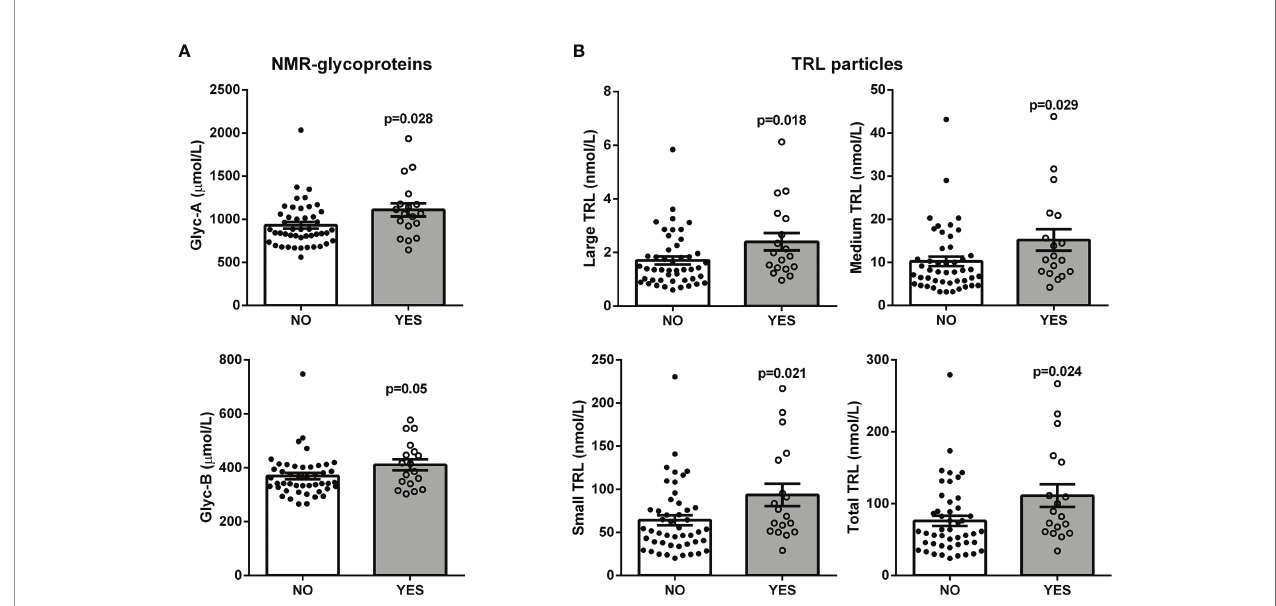
FIGURE 3 | Scatter plot with bar graphs of the plasma baseline levels of the NMR-measured glycoproteins (A) and TRL particles (B) in patients with ultrasound- con fi rmed hepatic steatosis after a 10-year follow-up. Each dot represents a patient: black dots for disease-free patients and white dots for patients with steatosis; bars represent mean values; p-values from Mann-Whitney U tests. Linear multivariate analysis controlled by age, sex and BMI: Glyc-A, p = 0.062; Glyc-B = 0.289; Large TRL-P, p = 0.001; Medium TRL-P, p = 0.004; Small TRL-P, p = 0.003; Total TRL-P, p = 0.003. In our study, we found a strong and positive association between all TRL particle subclasses and 1 H-NMR-measured glycoproteins Glyc-A and Glyc-B. Age, BMI and sex are known factors that in fl uence triglyceride concentrations (31).